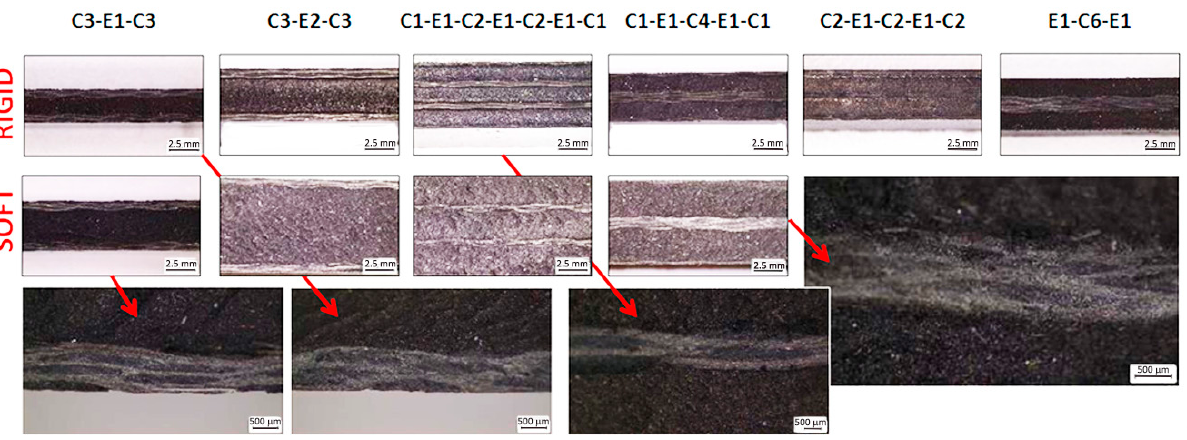
Figure 3. Cross-section of hybrid laminates and details of such interfaces.